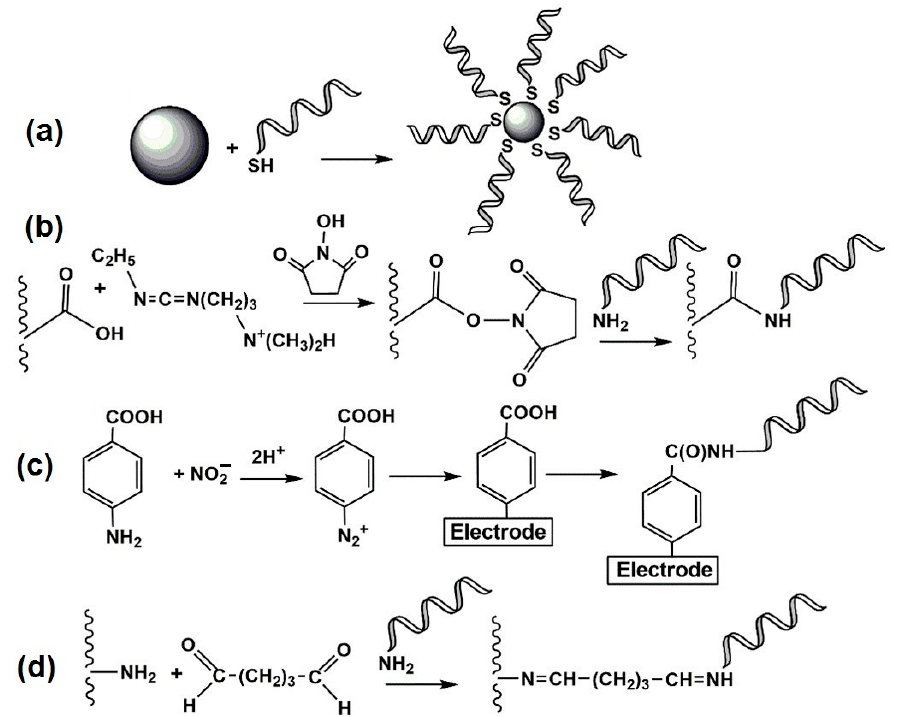
Figure 3. Aptamer immobilization protocols applied in the electrochemical aptasensors: ( a ) interaction of thiolated aptamer with Au nanoparticles/bare Au electrode; ( b ) carbodiimide binding to carboxylated support; ( c ) electrografting with diazonium salt generated from aromatic amino group; ( d ) cross-binding with glutaraldehyde of aminated aptamer and carrier.